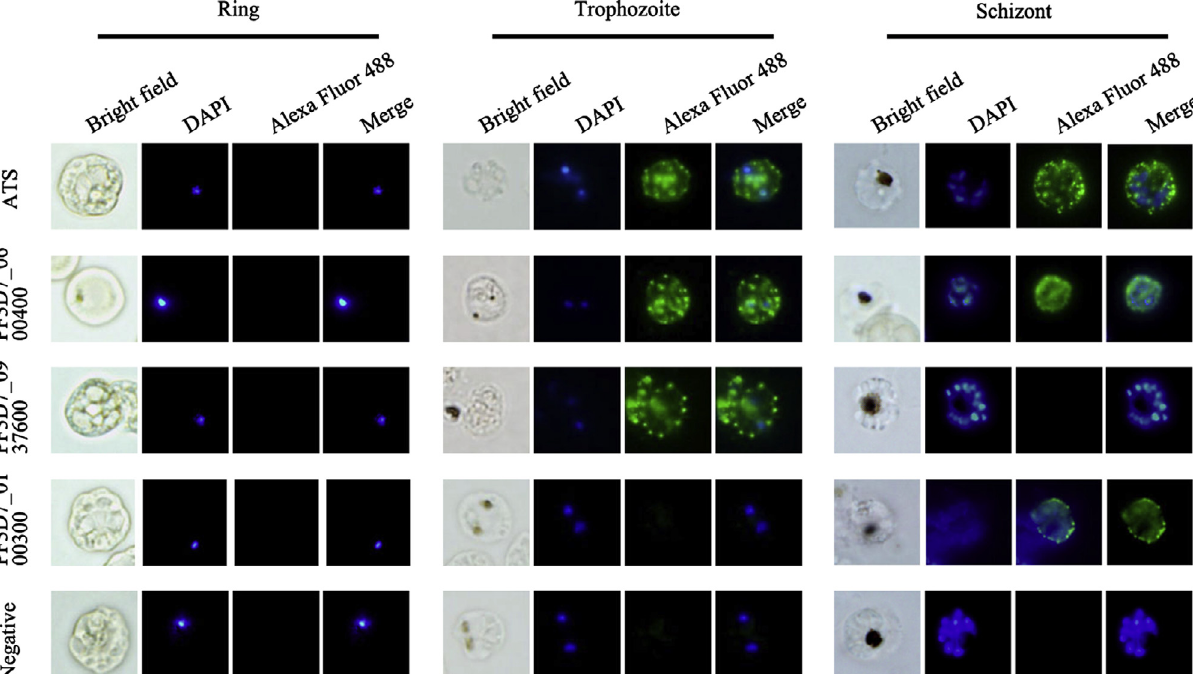
Figure 4. Immunofluorescence assays with variant-specific antibodies . An immunofluorescence assay (IFA) was performed using anti- PF3D7_0100300-His, anti-PF3D7_0600400-His, and anti-PF3D7_0937600-His IgG (1:50) as primary antibodies and anti-ATS IgG as the control. Specific staining of infected erythrocytes (IEs) is observed as punctuated fluorescence patterns over the IE surface using a secondary antibody labeled with Alexa 488 (green). The pre-immune sera of the immunized rats did not result in any surface reactivity with the IE. DAPI (5 l g/mL) staining of DNA in the nuclei is blue. The anti-ATS IgG and anti-PF3D7_0600400-His IgG stained IEs of both the trophozoite and schizont stages, the anti-PF3D7_0937600-His IgG only reacted with IEs of the trophozoite stage, while the anti-PF3D7_0100300-His IgG only reacted with IEs of the schizont